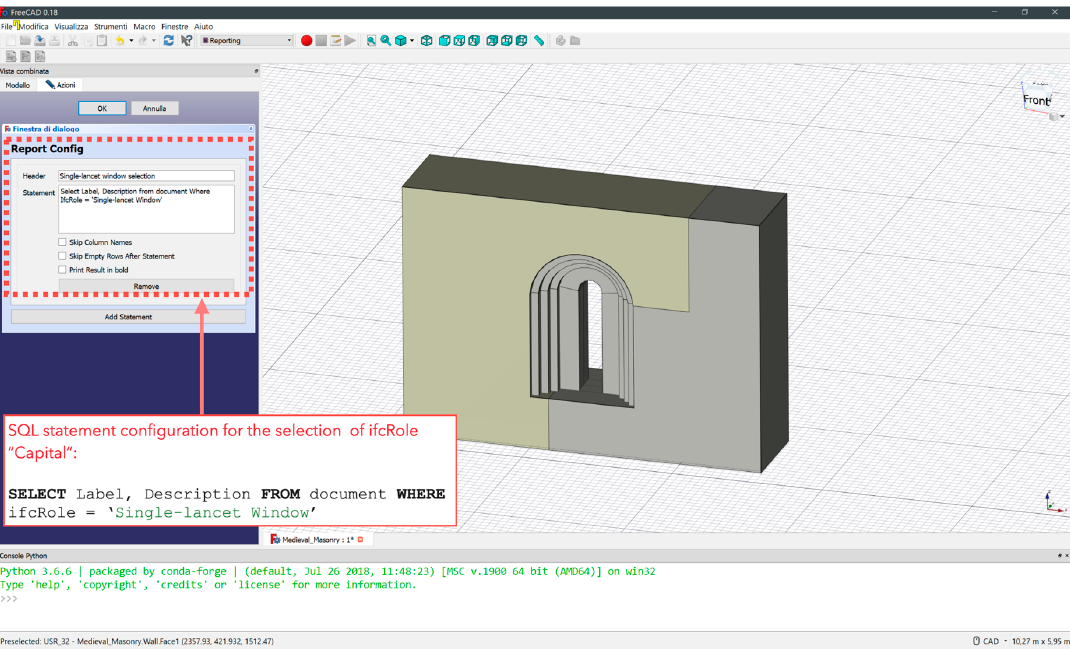
Figure 16. SQL query in order to investigate Rib IFC custom role referred to rib vault and their description: on the left side are the saved rib_selection_query and the related datasheet report with the query result.